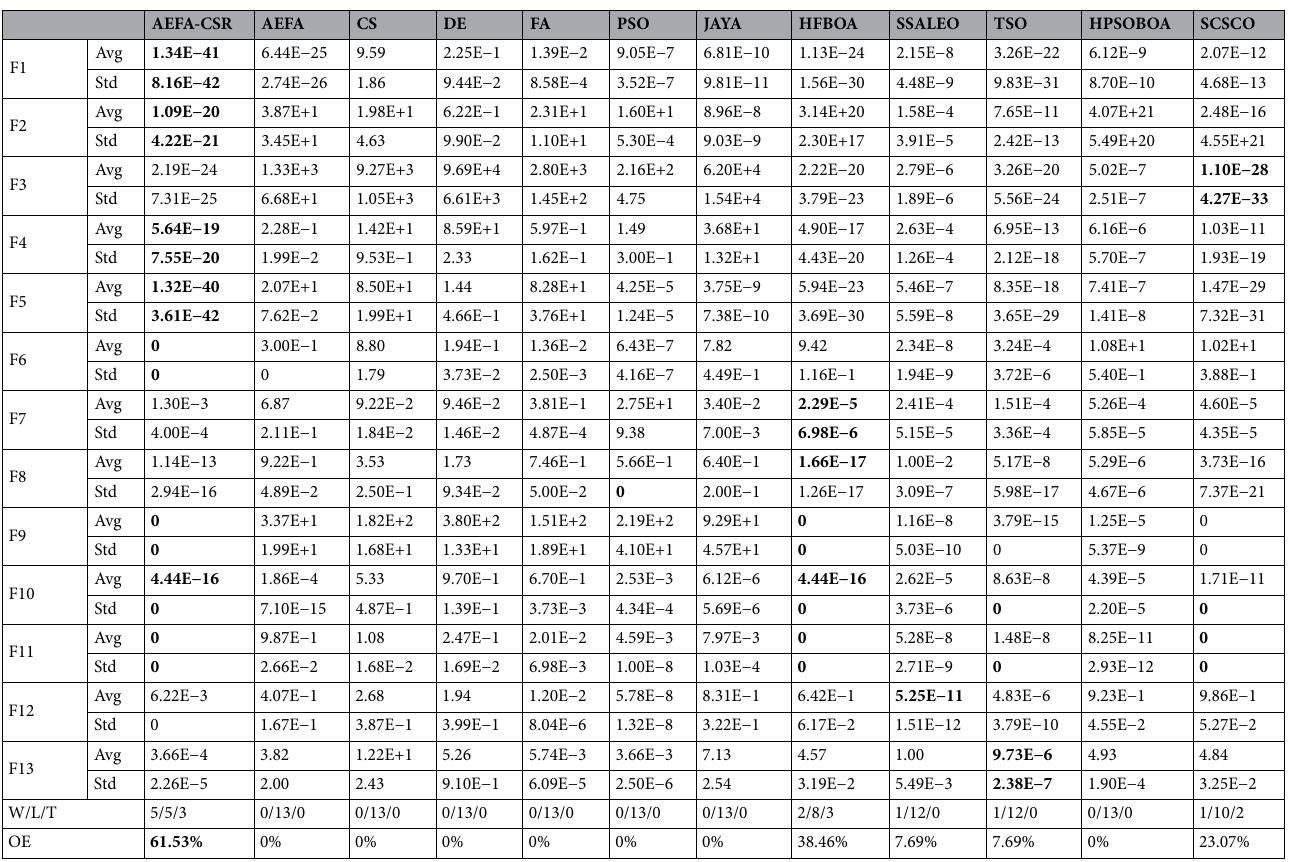
Table 6. F1–F13 comparison with dimension = 50 and population = 90. Significant values are in